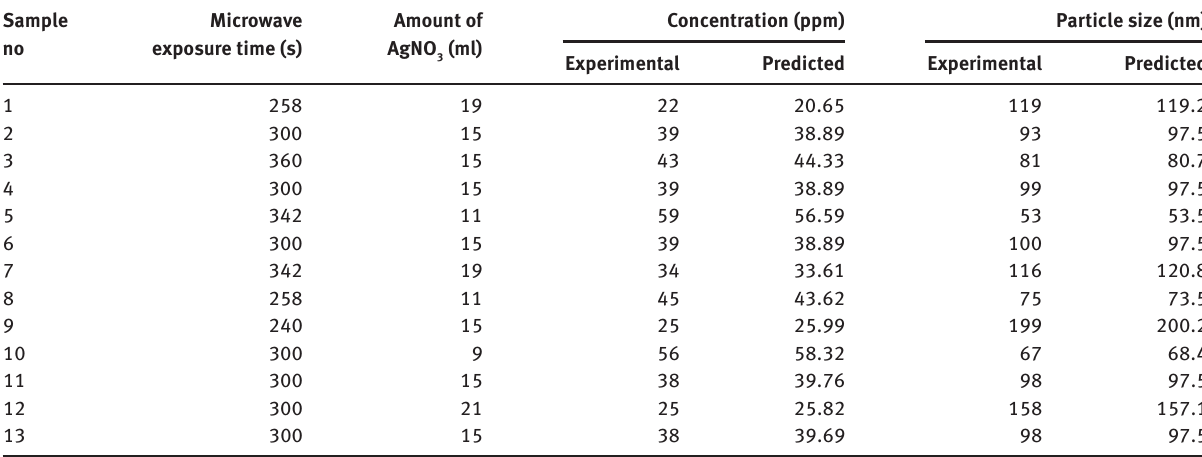
Table 1: Experimental runs according to the central composite design and response variables for AgNP synthesis.